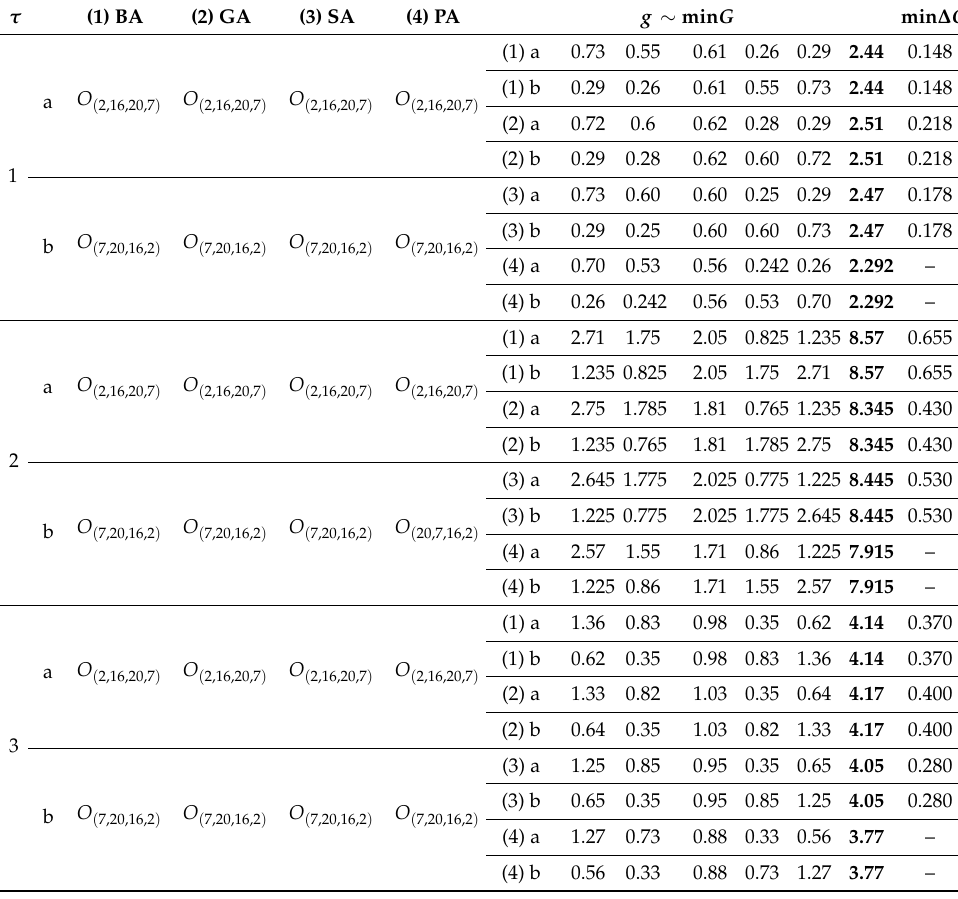
) on the route. Figure 15d–f show the global optimal solution differences min ∆ G ( Z o ( R to ( i ) , R to ( j ) ) between the BA, GA, SA, and the PA under the modes of τ = 1, τ = 2, and τ = 3, represented by the blue, orange, and green color, respectively. The minimum time expense t (min) for the travel process in the entire route is different for each algorithm. Table 8 shows a comparison of the traveling time of the optimal tour route for each algorithm. Figure 15g–i show the traveling time of the optimal tour route for each algorithm under different modes. The blue, orange, green, and gray colors represent BA, GA, SA, and PA, respectively. ) and the difference value Table 7. The comparison of the global optimal solution min G ( Z o ( R to ( i ) , R to ( j ) ) ) .The bold value of the weight g indicates the global optimal solution min G . min ∆ G ( Z o ( R to ( i ) , R to ( j ) )